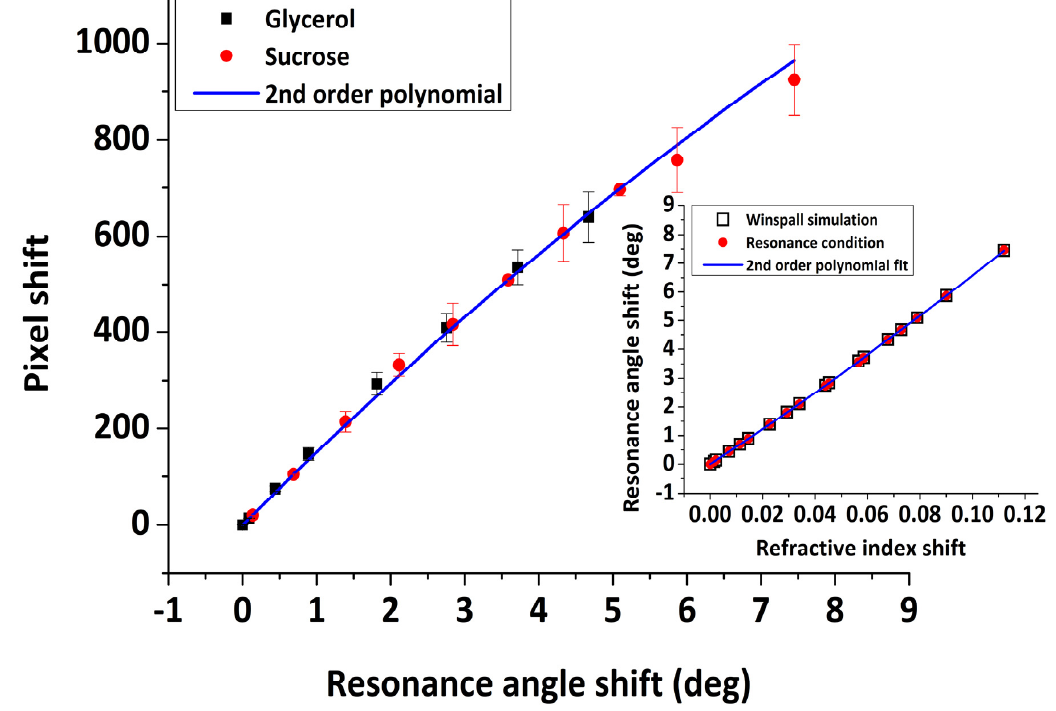
Figure 12. Pixel versus resonance angle shift. ( inset ) Angle shift versus optical index shift using Equation (3) and Winspall software simulations, normalized to water values.